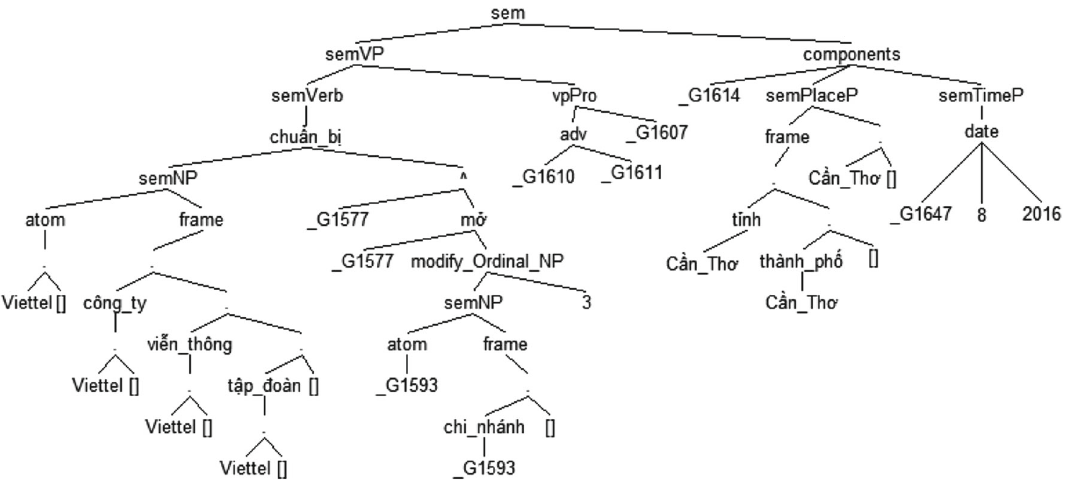
Fig. 2 Semantic tree of “Viettel vào tháng 8 n˘am 2016” with method in this research “ ” and “ ”